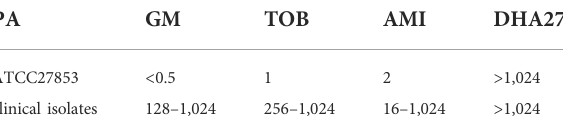
TABLE 2 Minimum inhibitory concentrations (MICs) of DHA27 and different aminoglycosides for Pseudomonas aeruginosa (PA) ATCC27853 and 20 clinical isolates of PA.